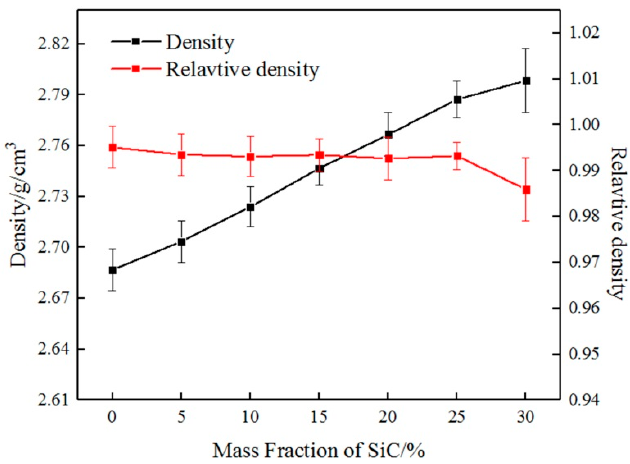
Figure 8. The variations in density and relative density with the mass fraction of SiC.